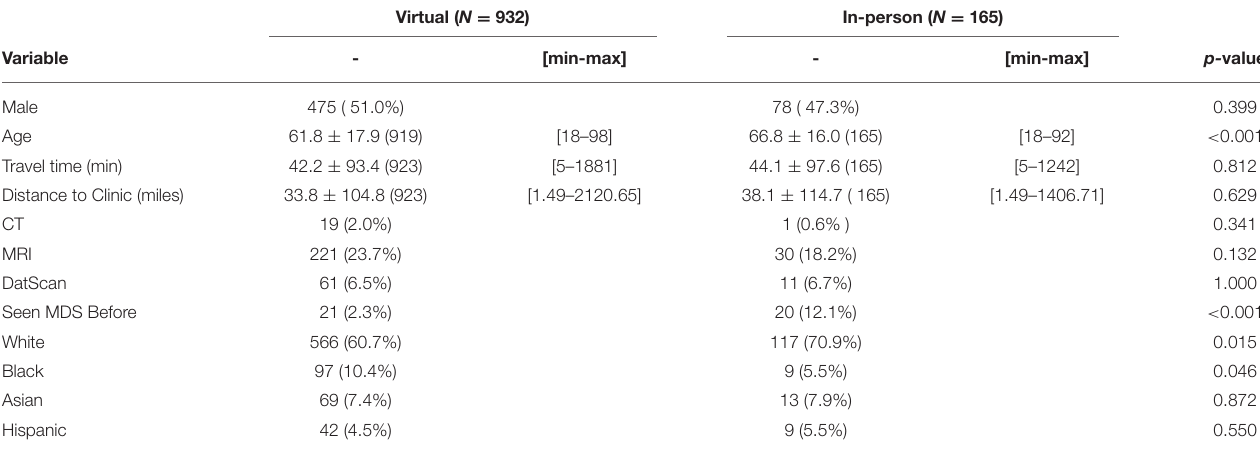
TABLE 1 | Characteristics of virtual and in-person cohorts.